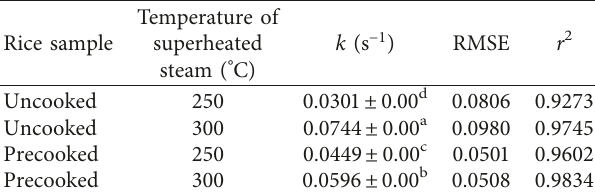
Figure 2: Change in moisture content of uncooked and precooked glutinous rice during superheated steam treatment. Table 1: Drying kinetic rate constant of black glutinous rice during superheated steam